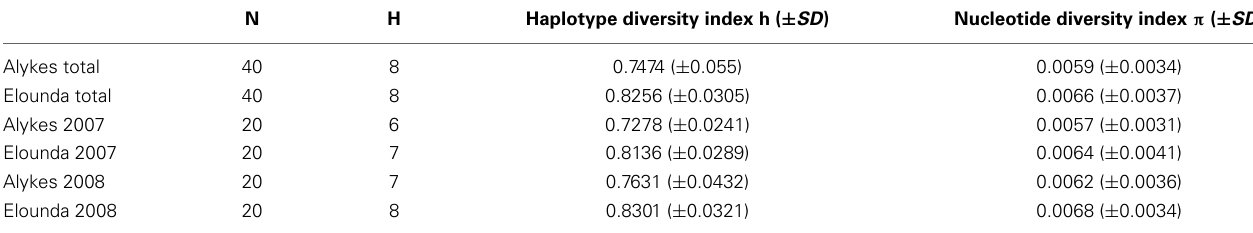
Table 2 | Diversity indices values, calculated for the two sampling locations and two sampling years; ± SD : standard deviation. N